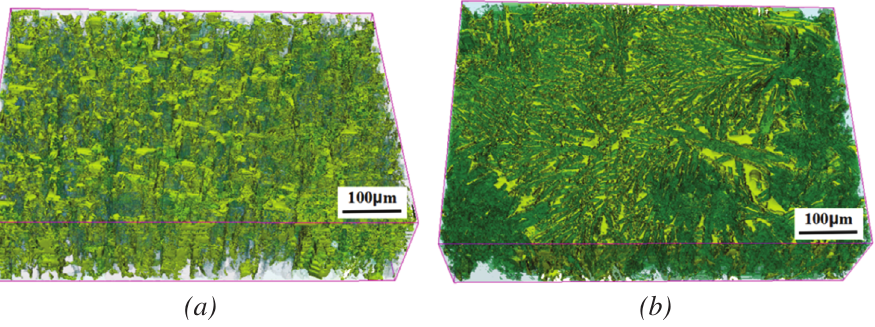
Figure 7: 3D perspective images of silicate in sinters. (a) Vanadium-titanium sinter; (b) Traditional